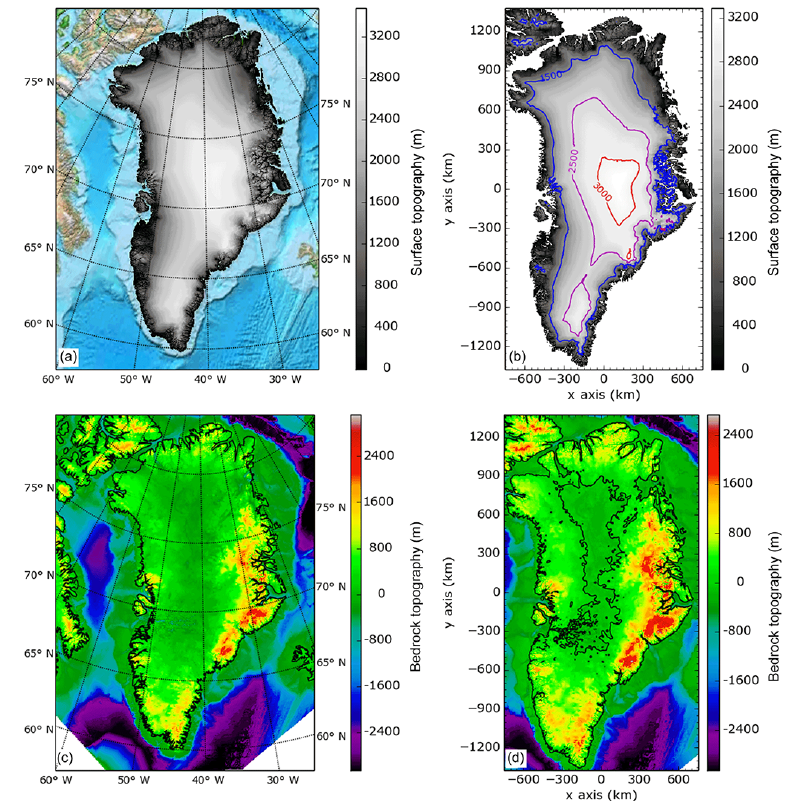
Figure 7. Panels (a, c) respectively show the surface topography and the bedrock topography of the 1km × 1km resolution data set for Greenland after an inverse projection on the Earth WGS84 ellipsoid. In (a) a coloured ETOPO background replaces the part at sea level. In (c) the missing values are white coloured and the continental contour is plotted black. In (b) the surface topography has been mapped on a 5km × 5km ISM grid with an optimal projection without using a mask, but points at sea level have been plotted white in order to visualize the coastline contours. In (d) the bedrock topography has been masked mapped on a 5km × 5km ISM grid with an optimal projection, the bottom right corner shows the proper resulting mask border. In (b) a few coloured contours are plotted on top of the data, and in (d) the zero contour is plotted